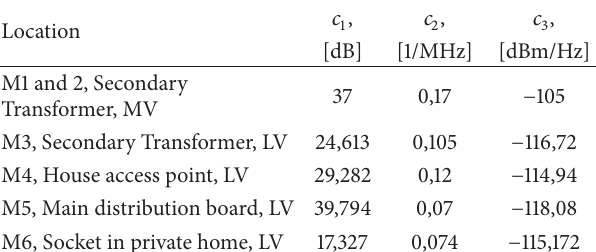
Table 2: Mean noise model coefficients [70] © 2010 John Wiley & Sons.